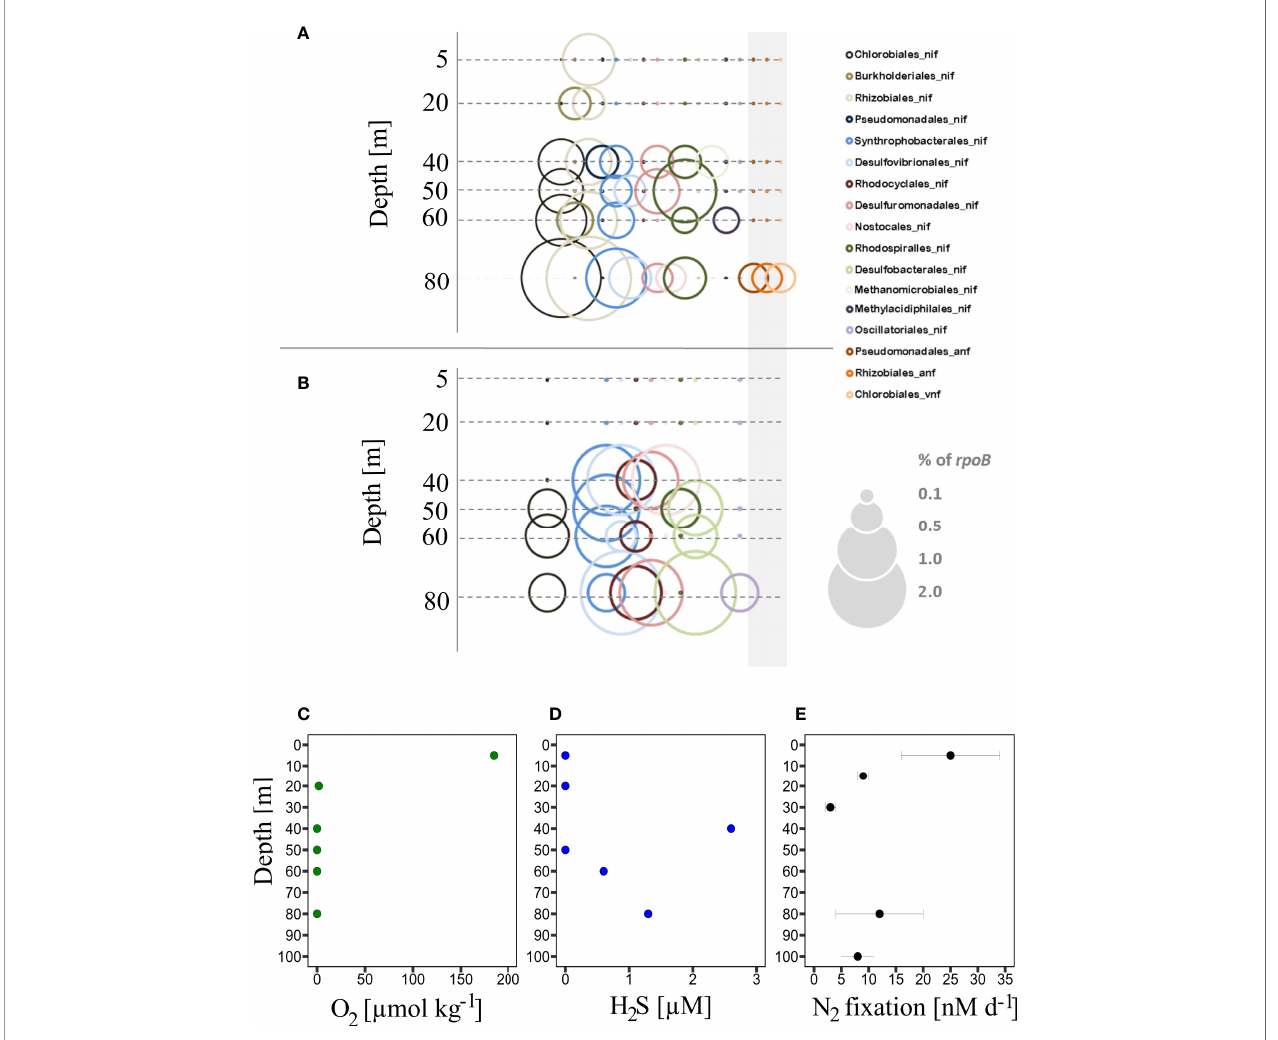
FIGURE 3 | Phylogenetic representation of organisms possessing nitrogenase genes of the nif , anf , or vnf type (all genes of the operons pooled) in metagenomes (A) and -transcriptomes (B) from the sul fi dic station. Genera identi fi ed from annotations of protein-coding genes (in the NCBI database) in both our metagenomes and – transcriptomes. Nitrogenase gene abundances and expression are shown relative to the putative single copy per organism of RNA polymerase subunit B ( rpoB ). The grey rectangle indicates the alternative nitrogenases anf and vnf , note that no expression of either of them was found. Vertical pro fi les from the Peruvian Shelf of O 2 (C) , H 2 S (D) and N 2 fi xation rate (E) are modi fi ed from Löscher et al.,